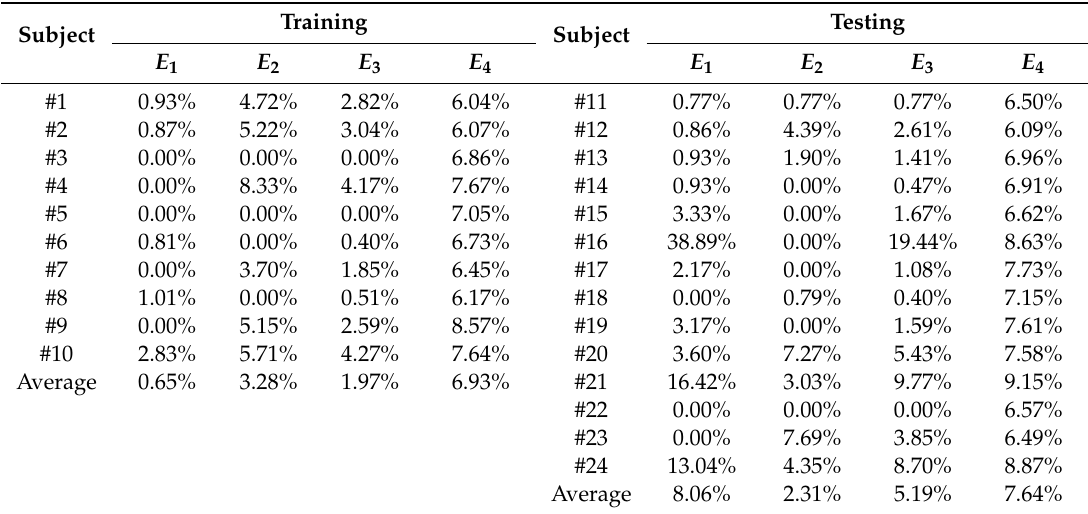
Table 4. Detection error rates of CSM compared with the reference method by training and testing sets.